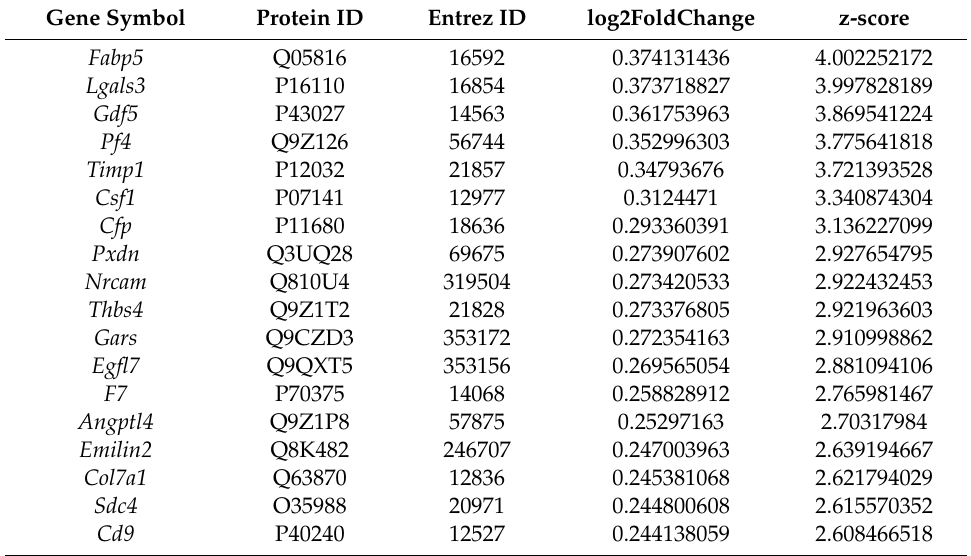
Table 1. Upregulated genes encoding secretory proteins following Myoparr knockdown in denervated tibialis anterior (TA) muscles of C57BL / 6J